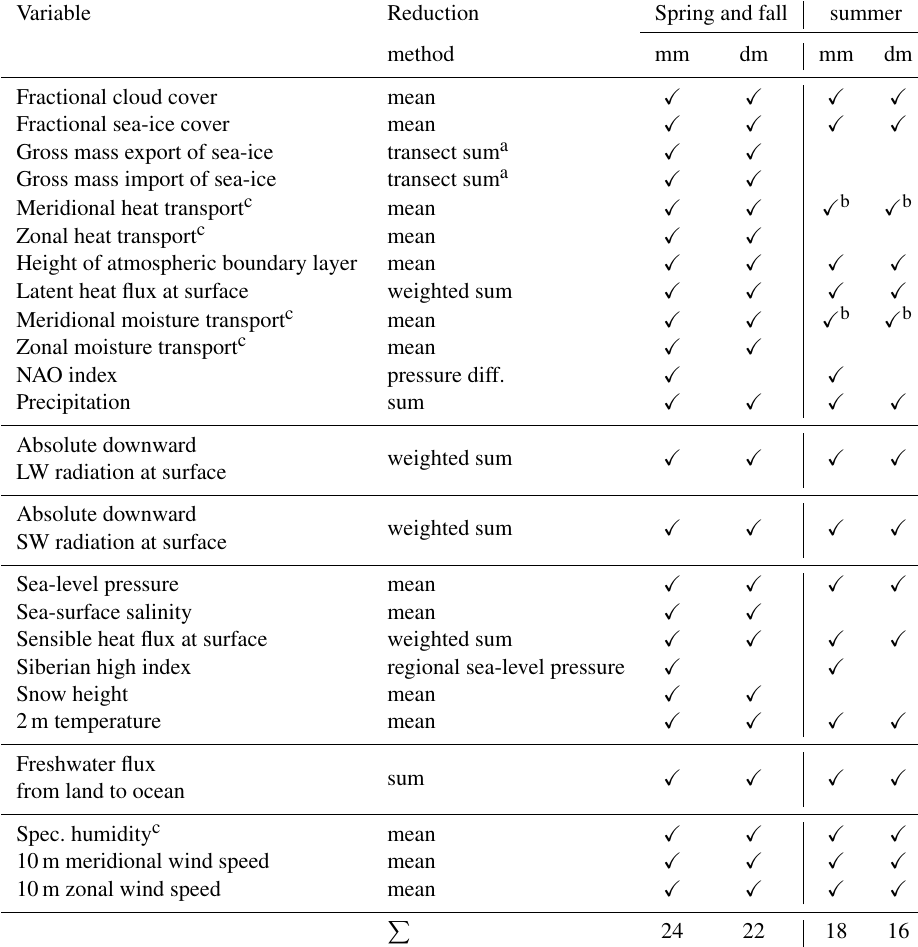
Table A1. Time series included in causal-effect networks of monthly means (mm) and daily means (dm) to determine dominant drivers of sea-ice in spring and fall in the Laptev Sea as well as the influence of sea ice on the atmosphere over land during the summer. While atmospheric variables were integrated over both land and ocean for spring and fall, only the atmosphere over land was used in the summer causal-effect